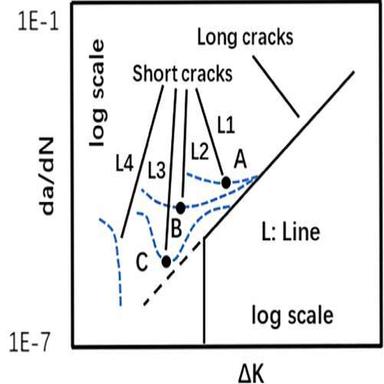
Crack propagation curves.